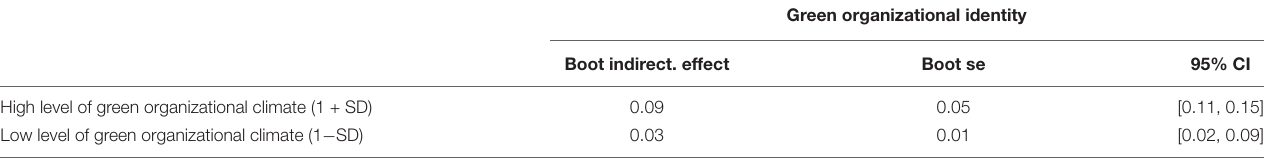
TABLE 5 | Results of the conditional indirect